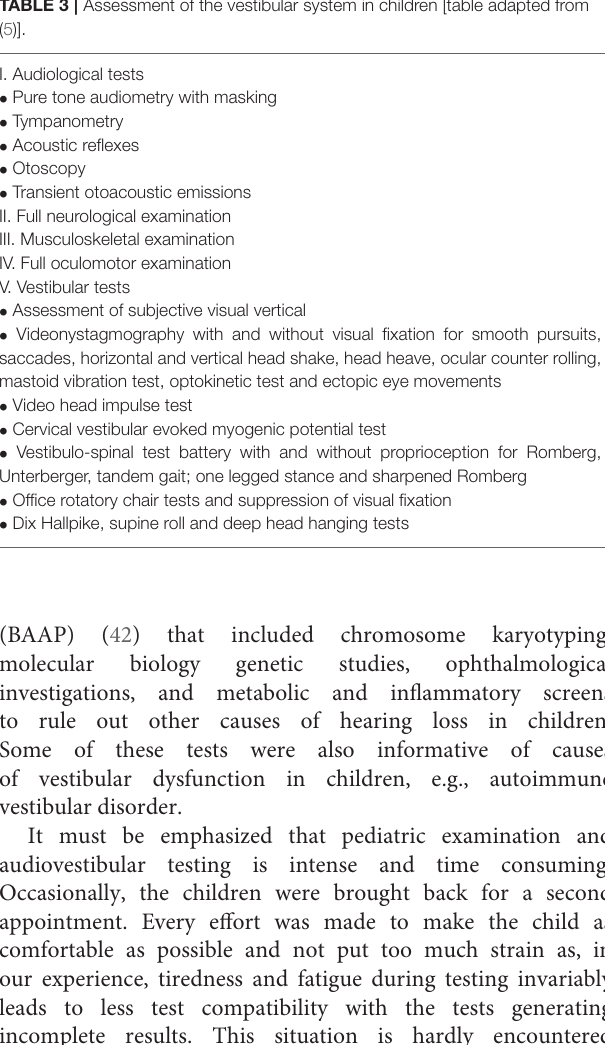
TABLE 3 | Assessment of the vestibular system in children [table adapted from (5)].